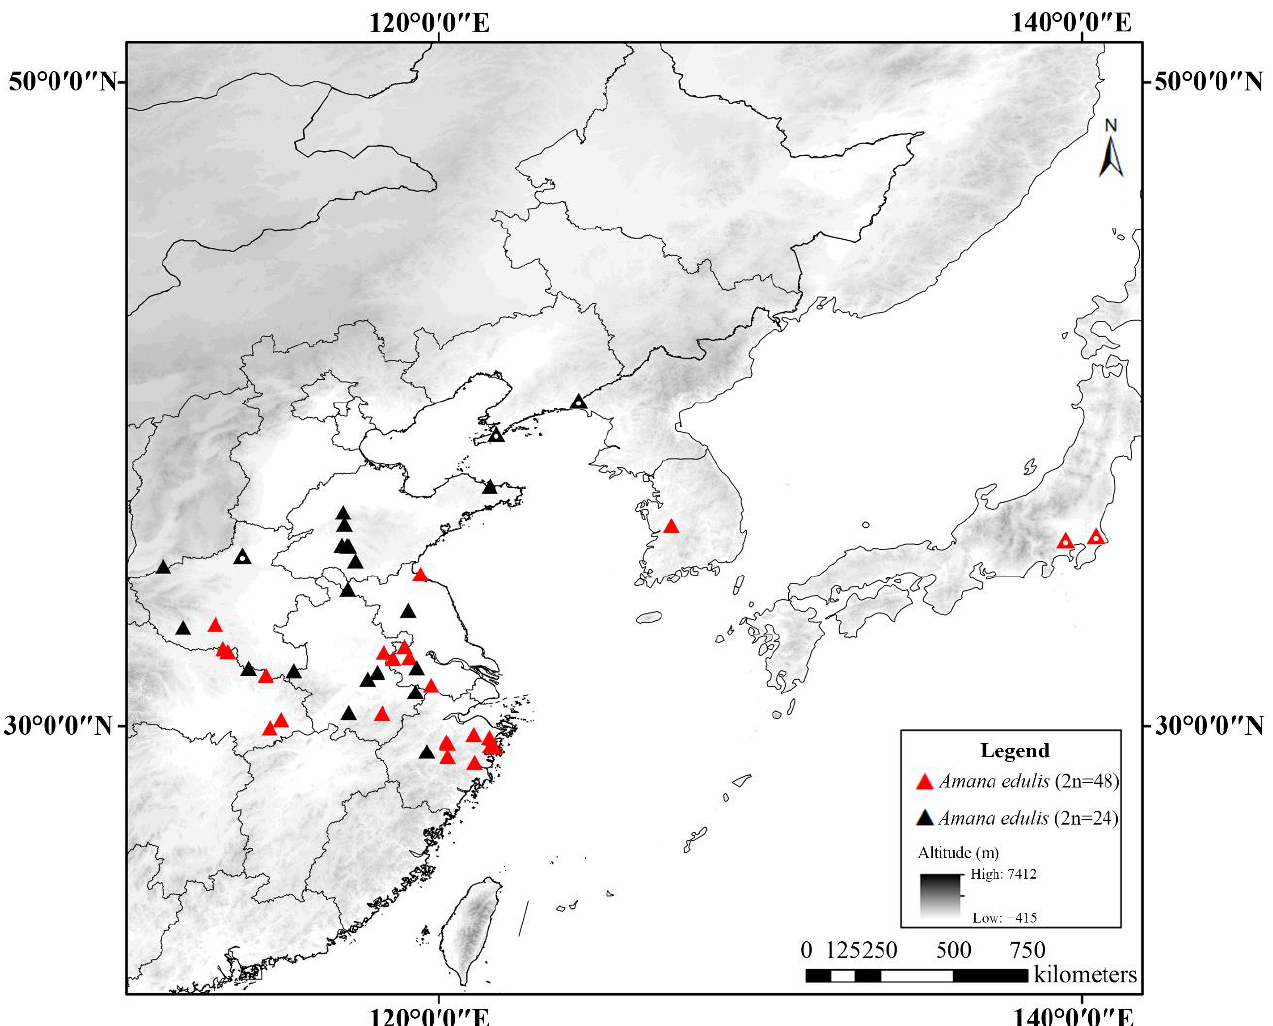
Figure 2. Distribution of ploidy levels of Amana edulis in China, Japan and the Korean peninsula based on present data. The red color represents tetraploid (2 n = 4 x = 48), and the black color represents diploid (2 n = 2 x = 24). The five populations centered with a white dot are based on previous studies (Deng, 2016 [19]; Sato, 1943 [21]; Noguchi and Kowano, 1974 [22]). Within Clade I, Amana nanyueensis is only found at several peaks of Mt. Heng in Hunan Province, China. It mostly grows in moist deciduous broadleaf forests on the mountain slope, at elevations of 950–1150 m. Two populations of A. nanyueensis that we sampled are both diploid (Table 1, Figure 3). Additionally, Amana tianmuensis is essentially distributed in southeastern Anhui and western Zhejiang Province, China (Figure 3). It grows in evergreen-deciduous broadleaved mixed forests or moist-deciduous broadleaf forests on the mountain slope, at elevations of 600–1500 m. Most populations (7/8)